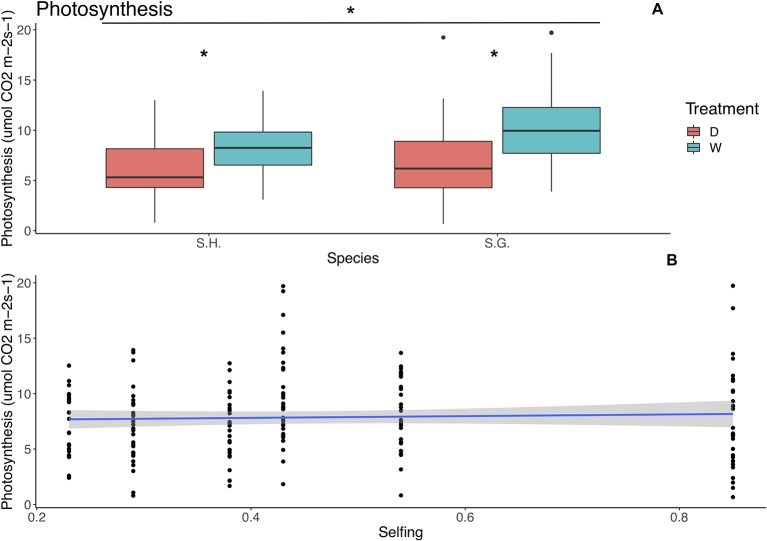
Relationship between photosynthetic rate (µmol CO2 m‑2 s‑1) and species (upper panel) and selfing rate (lower panel). (A) Red boxes represent the dry treatment and green boxes represent the wet treatment. S.H., Schizanthus hookeri; S.G., Schizanthus grahamii; D, dry treatment; W, wet treatment. (B) Blue line represents linear relationship and the gray area is the standard error. Significance level: *P < 0.01.